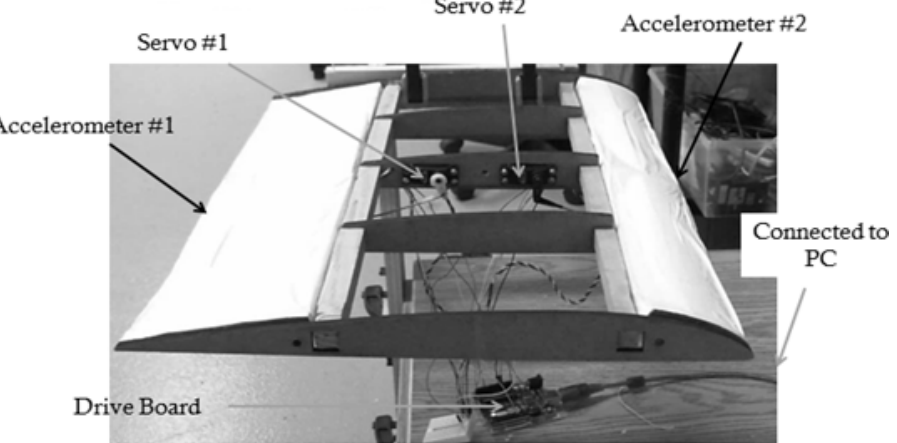
Figure 18. Adaptive wing prototype instrumentation and sensors.